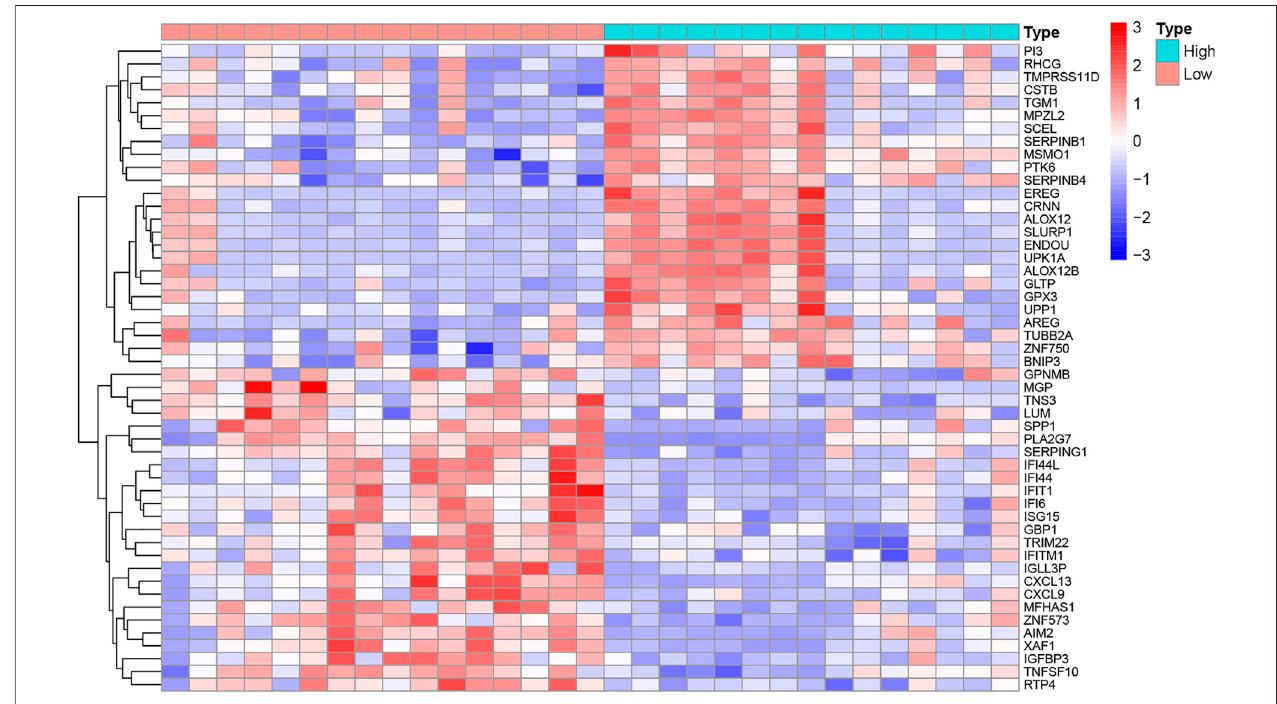
FIGURE 3 | Heat map of differential gene expression in GSE7803.